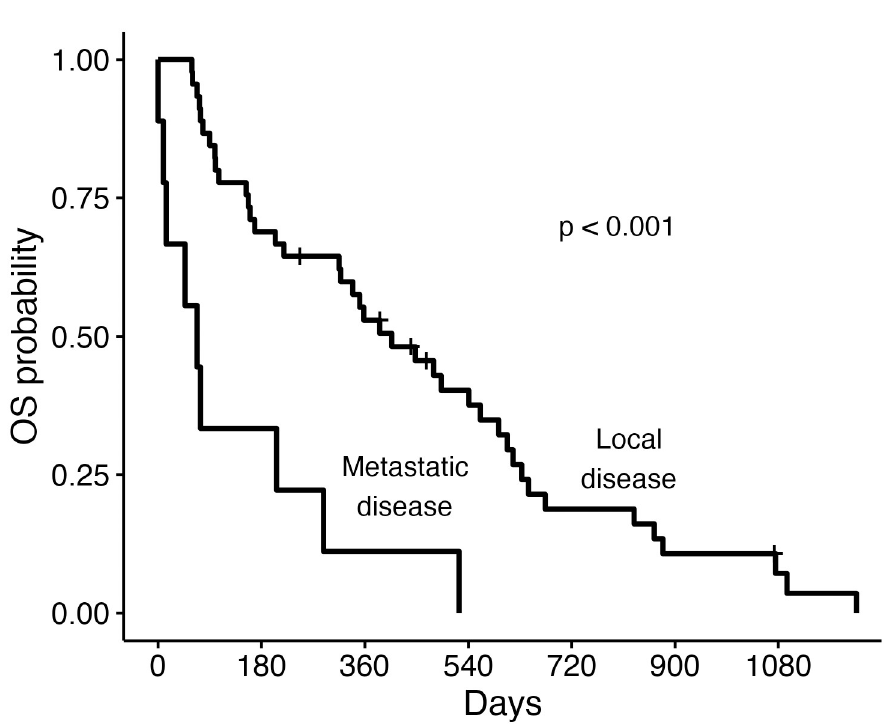
Fig 6. Overall median survival time for dogs with adenocarcinoma with and without metastasis. Overall survival (OS) curves for dogs with lung adenocarcinoma that presented with (N = 9 dogs) or without metastasis (N = 45) at the time of diagnosis. Ticks represent dogs censored from analysis. Dogs were censored if they were alive at the time of last follow-up. The median overall survival time (OST) for dogs with adenocarcinoma that presented with local disease was 407 days (95% confidence interval [CI]: 315–608 days) while the median OST for dogs with metastasis was 68 days (CI: 14-not found).